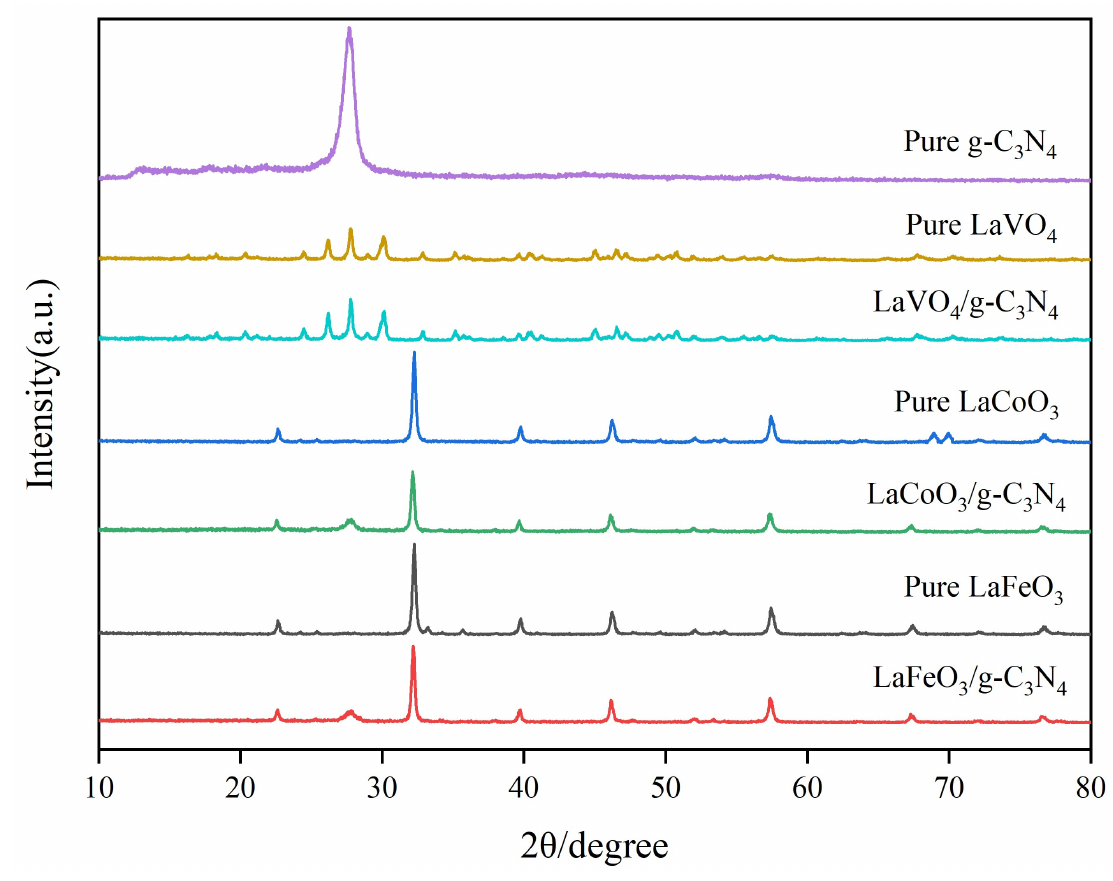
Figure 1. XRD patterns of obtained